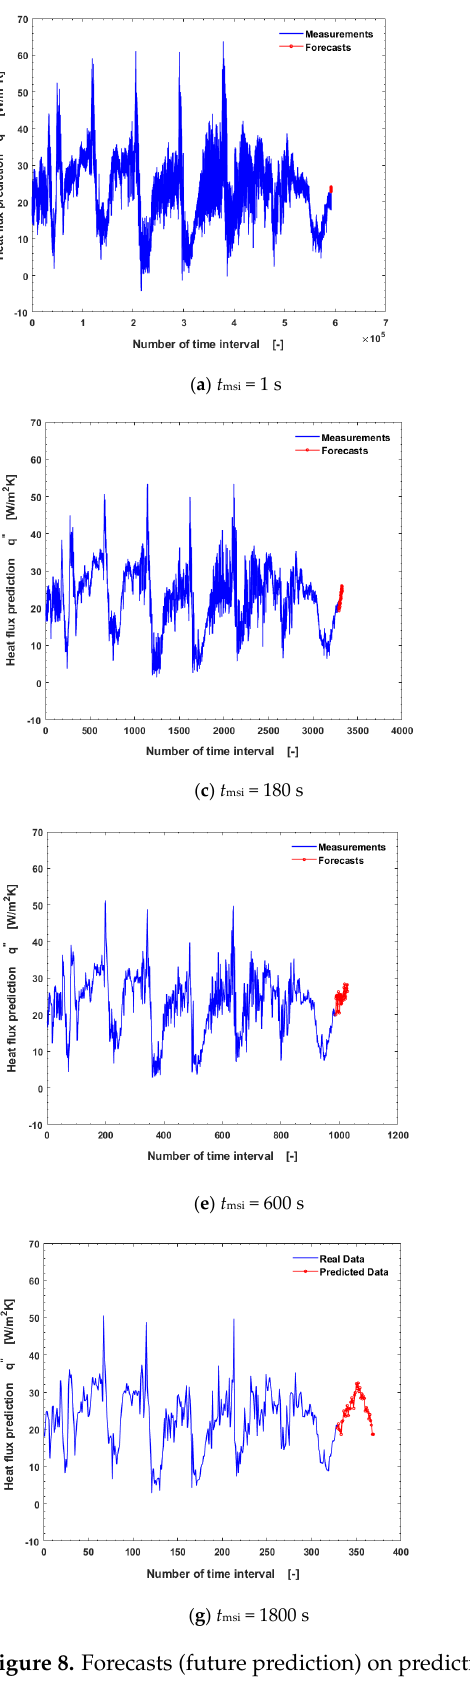
Figure 7. Evaluation of regression graph for all data using LSTM model.